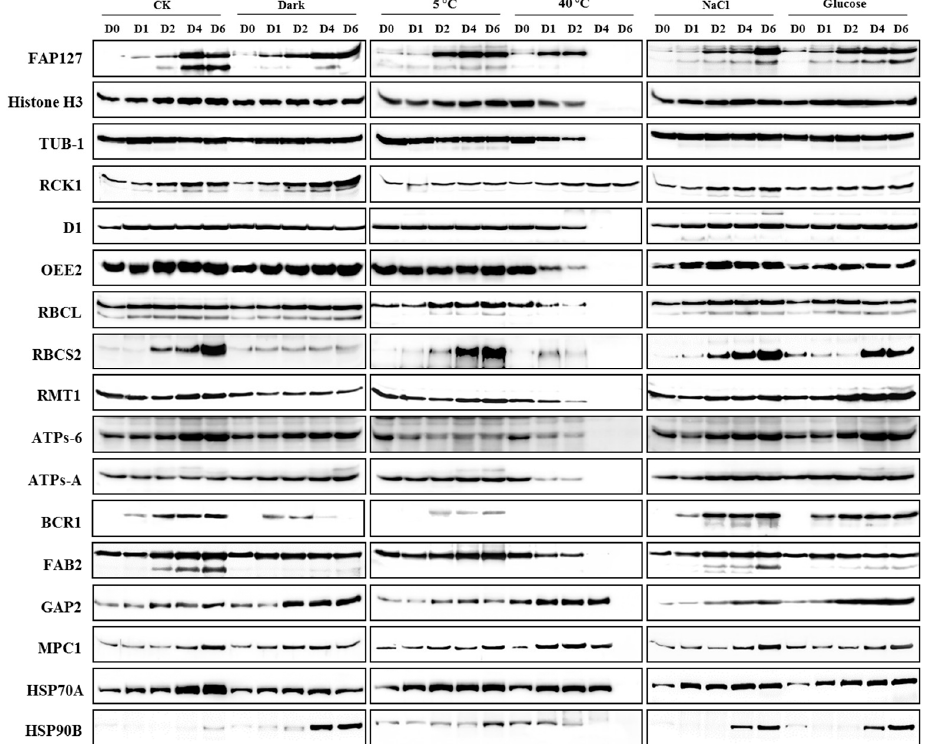
Figure 4. Western blot detection of candidate proteins in Chlamydomonas reinhardtii cells under abiotic stresses at different time points. C. reinhardtii cells cultured under different abiotic stress conditions were collected at five time points. Total proteins were extracted and separated by SDS-PAGE. PVDF-membrane-immobilized proteins were detected by antibodies against 20 candidate proteins. CK, Dark, 5 °C, 40 °C, NaCl, and Glucose are treatments for C. reinhardtii cells. D0, D1, D2, D4, and D6 are the time points (days) of sample collection.